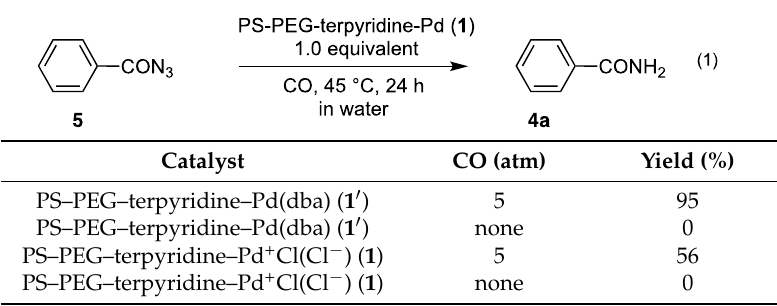
Scheme 3. Proposed reaction mechanism of aminocarbonylation in water. Table 3. Stoichiometric Table 3. Stoichiometric reaction. Table 3. Stoichiometric reaction.